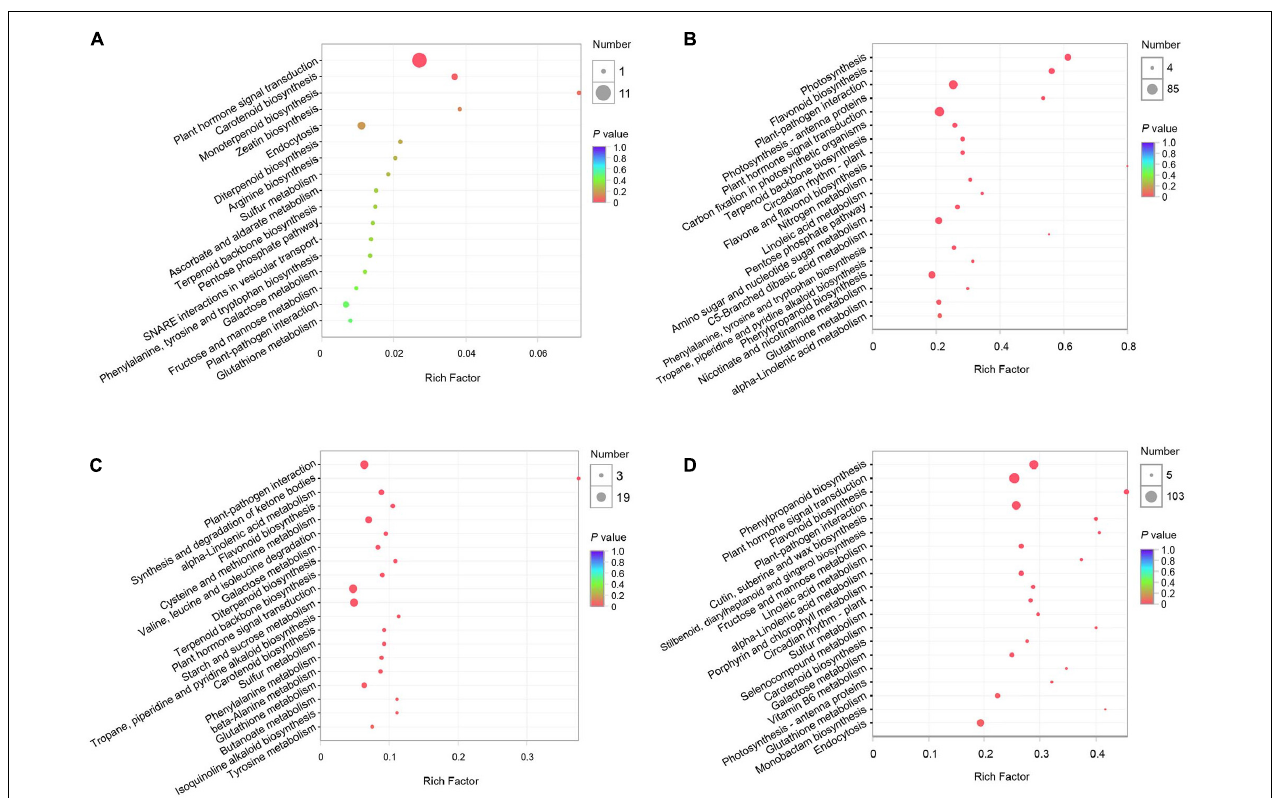
FIGURE 3 | Kyoto Encyclopedia of Genes and Genomes (KEGG) pathway enrichment analyses of DEGs of P. pyrifolia at QS and NS in response to the infection of two C. fructicola strains. (A,B) KEGG pathway enrichment of DEGs response to strain PAFQ31 at QS (A) and NS (B) , respectively. (C,D) KEGG pathway enrichment of DEGs response to strain PAFQ32 at QS (C) and NS (D) ,